Question: What caption would you write for this figure?
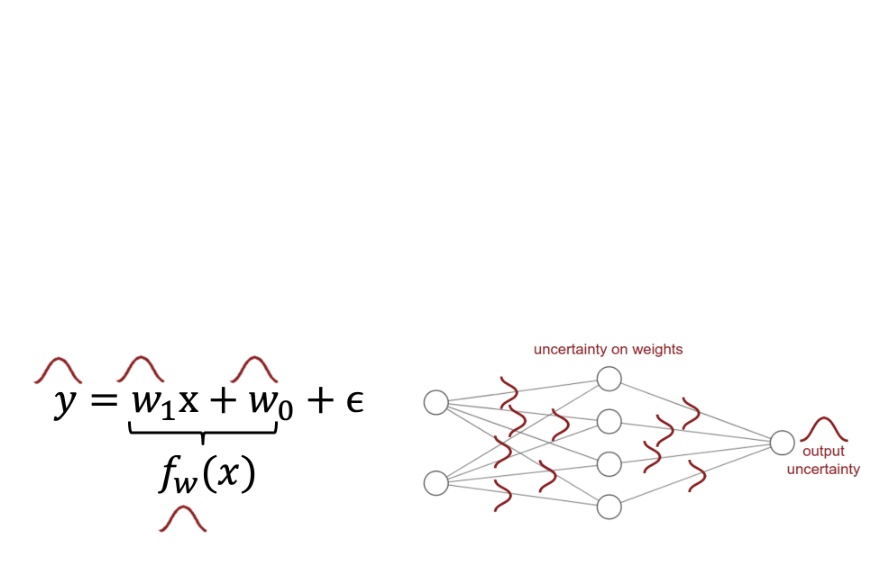
Answer: We need many models to quantify the epistemic uncertainty. This can be done explicitly by having multiple models as in ensembles or implicitly by introducing probability distributions over the parameters (weights of the neural network) of the ML model.